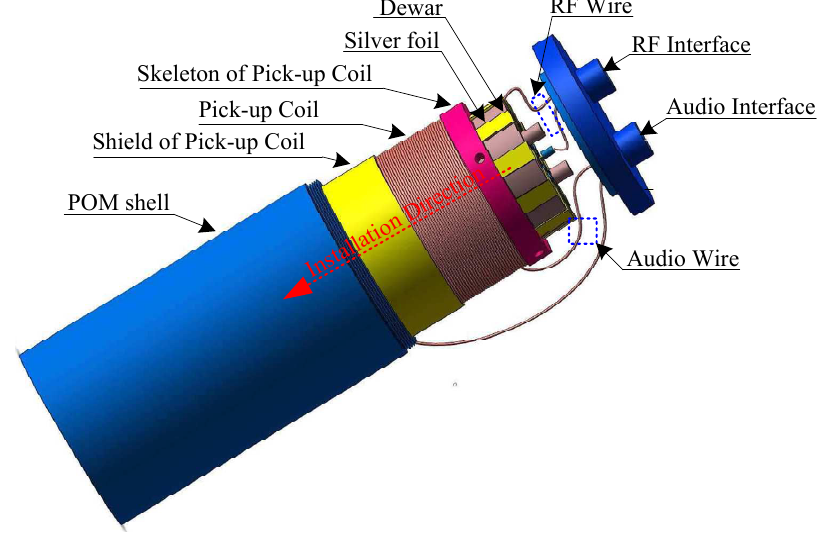
Figure 11. Composition of the Overhauser sensor.